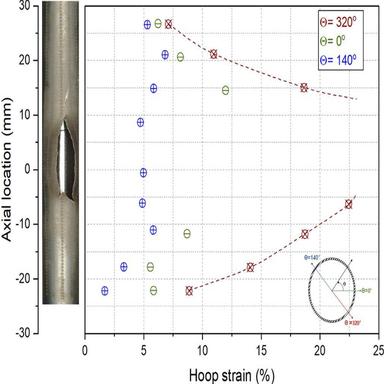
Permanent hoop strain distribution along the axial direction at three different orientations.